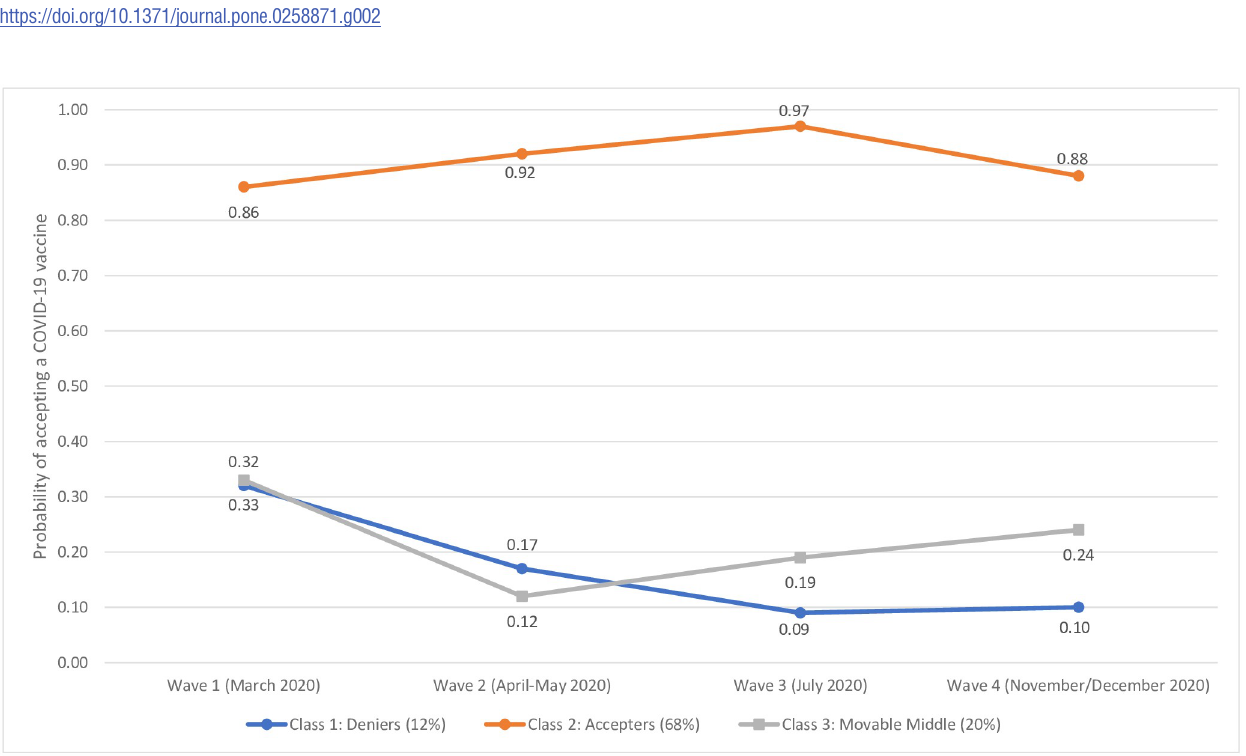
Fig 3. Latent class probabilities of COVID-19 vaccine acceptance in the UK sample. Data are presented as the latent class probabilities of COVID-19 acceptance in the UK sample (N = 2000) across four waves of data collection.